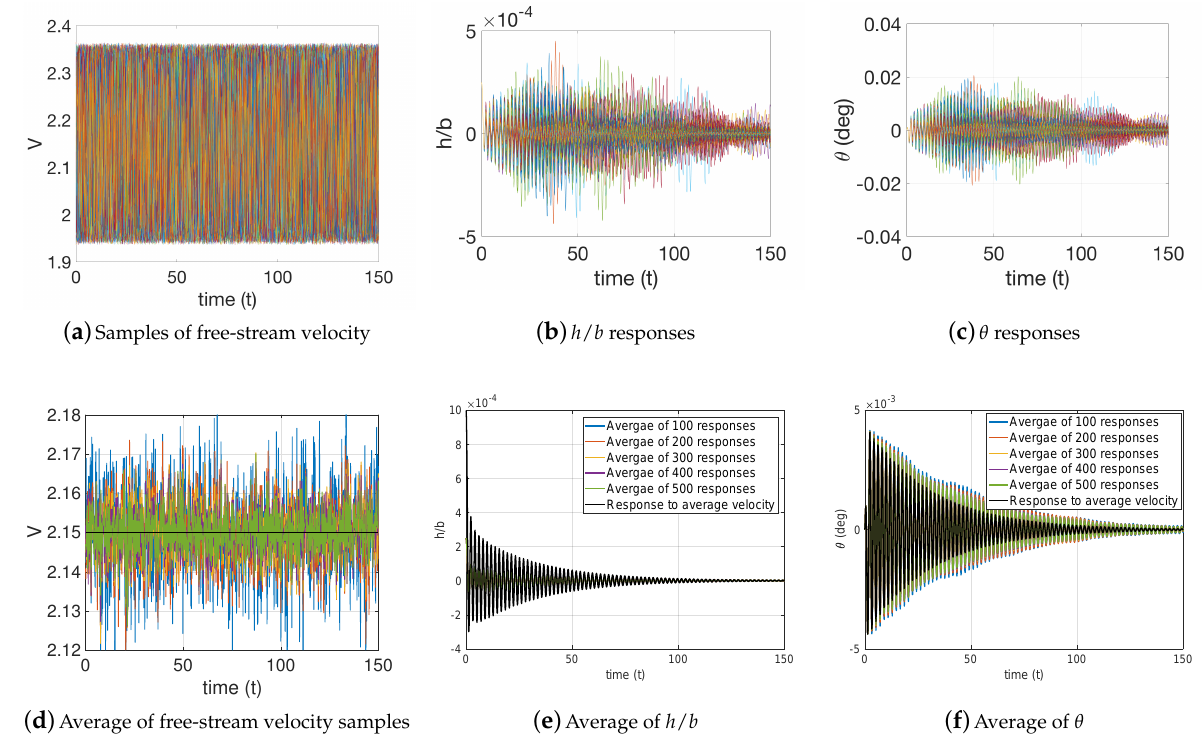
Figure 13. Illustration of law of large numbers with 500 samples for a stable average velocity, for V ave = 2.15 for α = 20, and ∆ = 0.1.